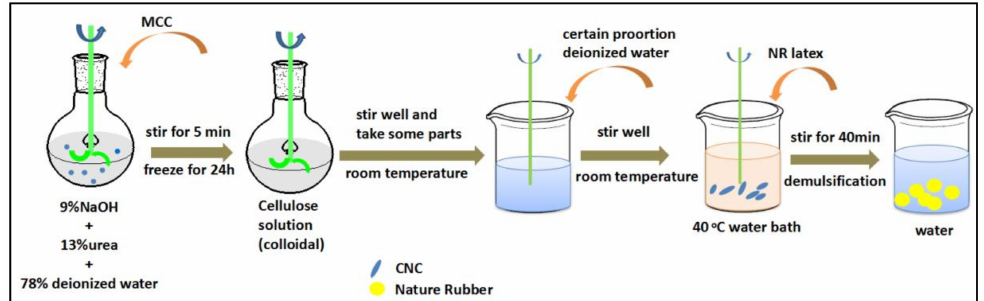
Figure 8. Preparation route for RRC/NR